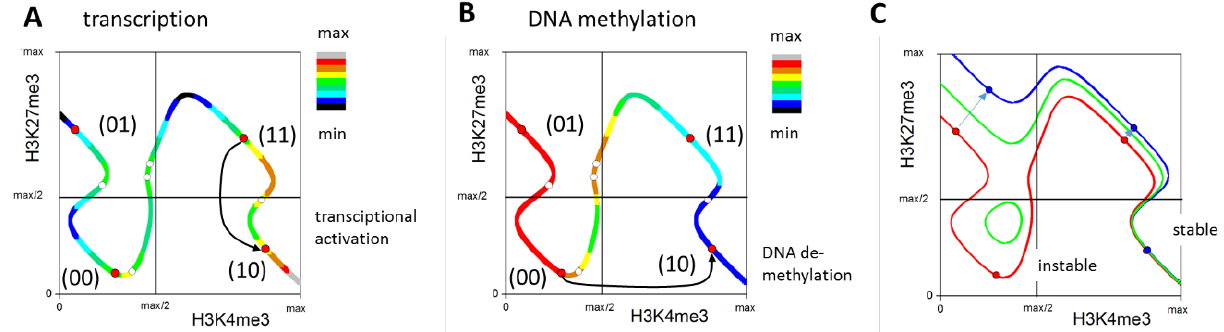
Figure 8. Hypothetical regulation of the cluster f , g and h genes. ( A , B ) Phase diagram of the H3K4me3 and H3K27me3 states of a single gene as introduced by reference [12]. The line shows the states that are consistent with histone modification dynamics for high DNA methylation activity. Each state along the line is associated with a specific transcription and DNA methylation (see: color codes in ( A , B ), respectively). Only a few states are consistent with the transcriptional regulation of the gene (circles); among them, four are stable fixed points (red circles). The transitions between the fixed points due to fluctuations are common. For the cluster f and g genes, gene activation by the transcription factors results in a preference for the H3K4me3 state ( A ). The unmodified state is globally stable. Accordingly, in order to leave it, cluster h genes require DNA demethylation, rendering the state unstable ( B ). ( C ) Stable fixed points change for the decreasing DNA methylation activity (red: high; green: middle; blue: low activity).